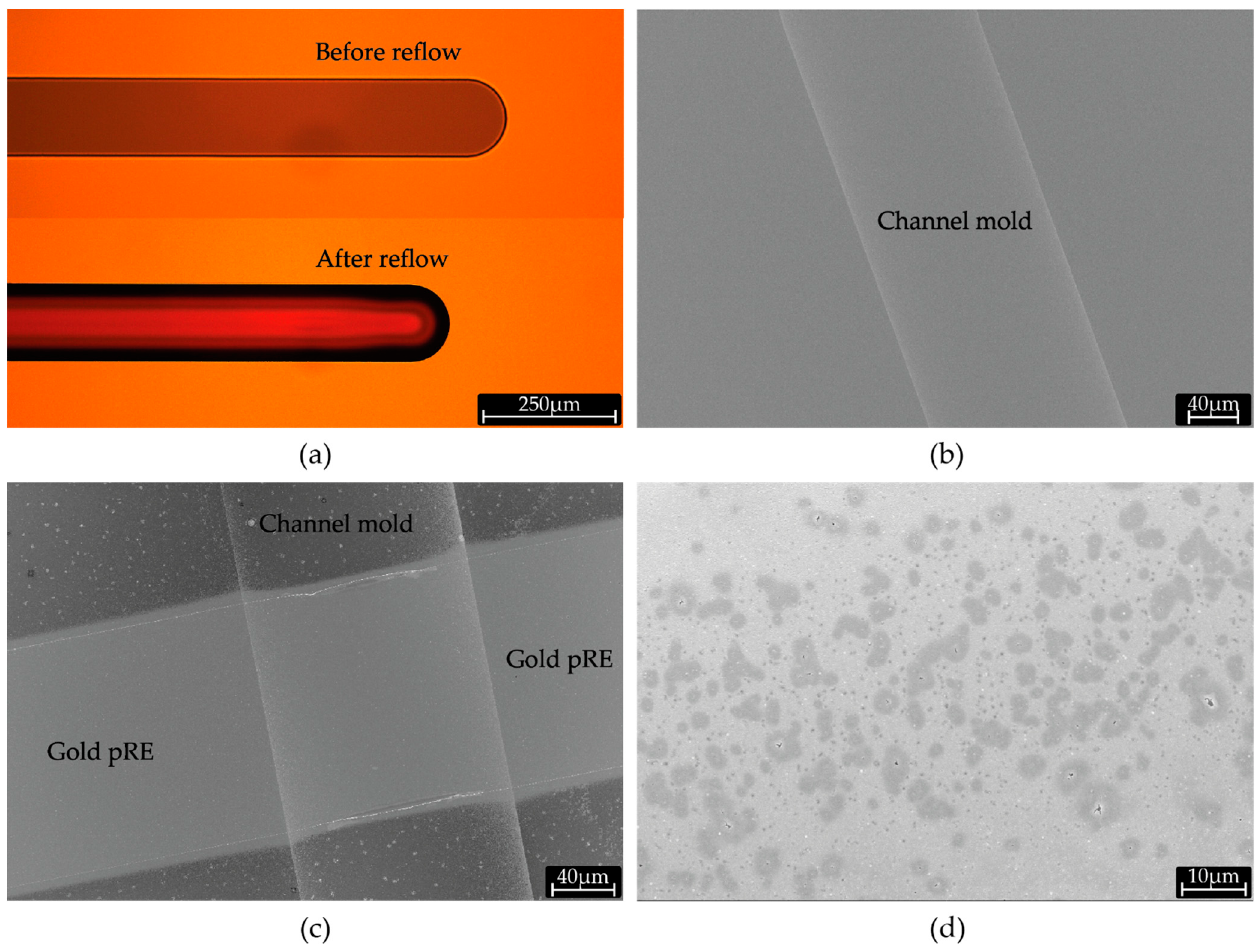
Figure 3 . ( a ) Optical micrograph of negative mold for microfluidic channel before and after reflow of AZ 10XT resist. ( b ) SEM image of negative mold after sputtering of aluminum. ( c ) SEM micrograph of a gold pseudo-RE line conformally covering the negative channel mold. ( d ) SEM micrograph after development with KOH based developer, showing dark regions of etched aluminum under the pinholes in the Titanium layer.